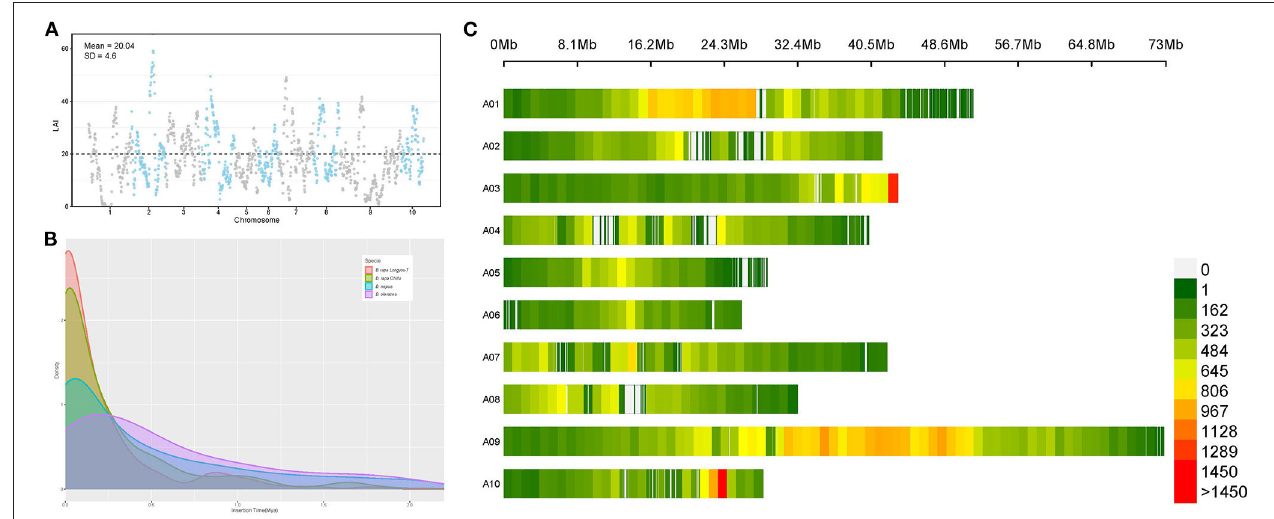
FIGURE 3 | LTR insertion events in B. rapa “Longyou-7” genome. (A) LAI score reflects the quality of repetitive sequences of B. rapa “Longyou-7” genome assembled, with mean LAI = 20.04, SD = 4.6; (B) Insertion time distribution of LTR retrotransposons in B. napus , B. oleracea , B. rapa , and B. rapa “Longyou-7” genomes; (C) The distribution of LTR-RTs density in each chromosome of B. rapa “Longyou-7”.